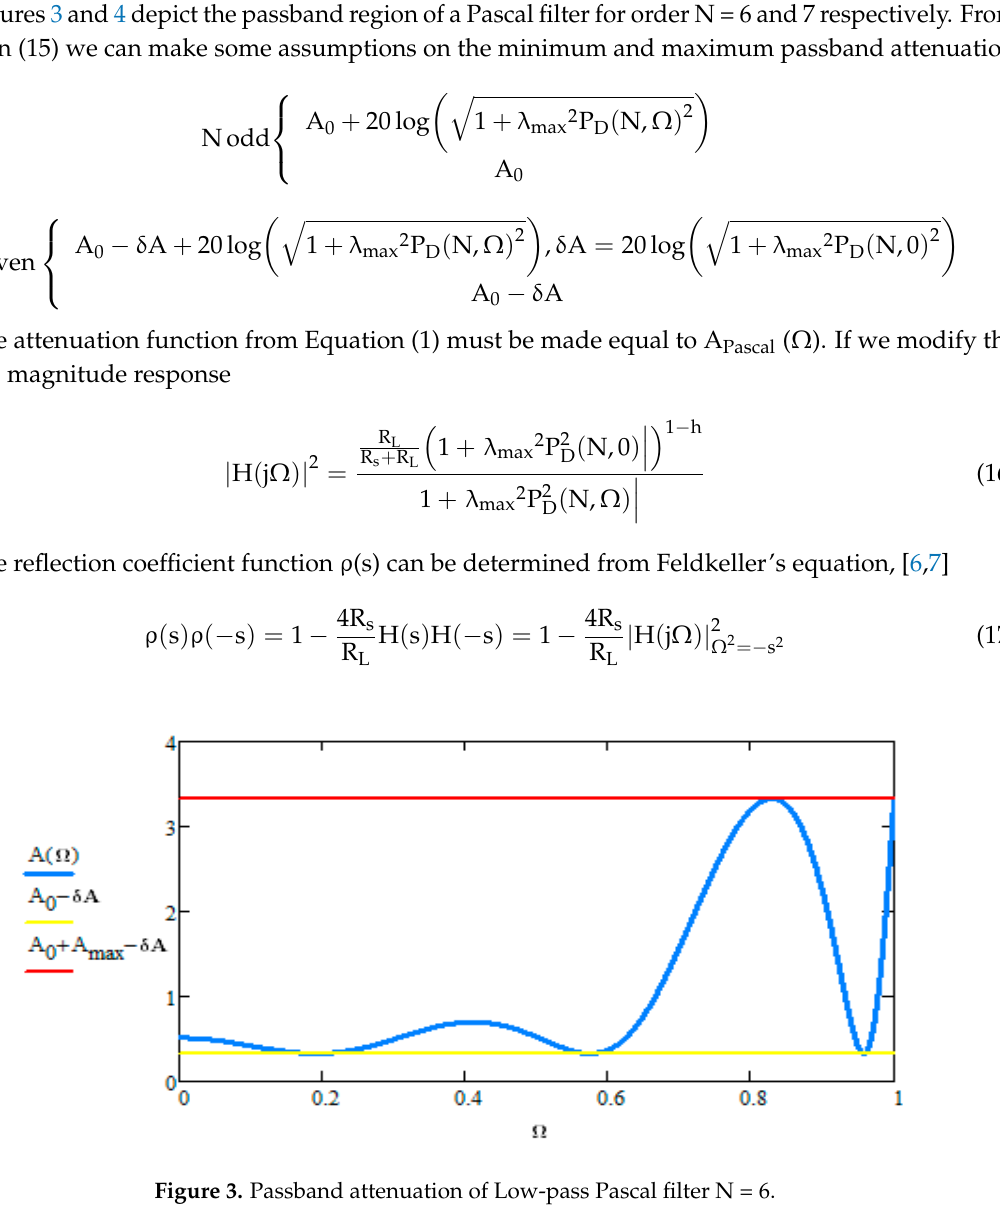
Figure 4. Passband attenuation of Low-pass Pascal filters N = 7. The reflection coefficient function obeys two major rules: 1.